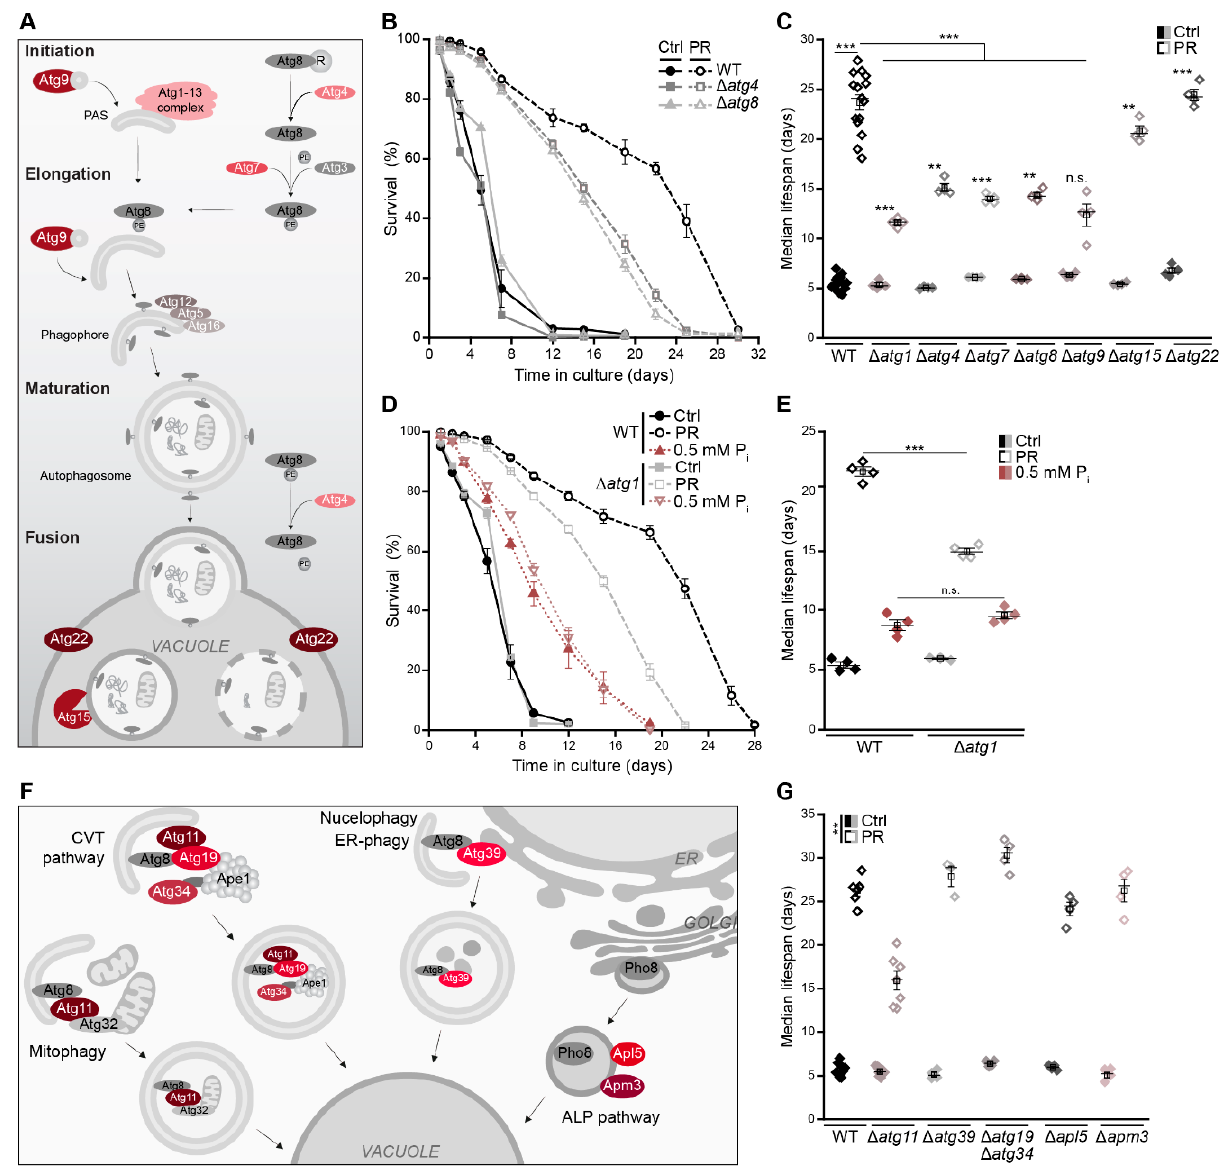
Figure 4. Autophagy supports long-term survival of phosphate-limited cells. ( A ) Schematic overview of key players involved in macroautophagy. ( B ) Survival during chronological aging, determined via flow cytometric quantification of PI staining, of WT, ∆ atg4 and ∆ atg8 cells grown on standard (Ctrl) or phosphate-restriction (PR) media; n = 4. ( C ) Median lifespan of WT cells and mutants lacking core autophagy genes (ATG1, ATG4, ATG7, ATG8, ATG9, ATG15 and ATG22 ) grown on Ctrl and PR media; n ≥ 4. ( D , E ) Survival during chronological aging ( D ) and corresponding median lifespan ( E ) of WT and ∆ atg1 cells grown in media containing standard phosphate concentrations (7 mM; Ctrl), 0.5 mM or 0.2 mM phosphate (PR); n = 4. ( F ) Schematic overview of selective autophagy and the ALP pathway. ( G ) Median lifespan of WT cells and mutants lacking genes involved in selective autophagy and the ALP pathway, as depicted in ( F ), grown on Ctrl or PR media; n ≥ 3. For statistical analysis, Welch–ANOVA with Dunnett T3 post hoc ( C , F ) and one-Way ANOVA with Tukey post hoc ( E ) were used. ** p < 0.01 and *** p < 0.001.